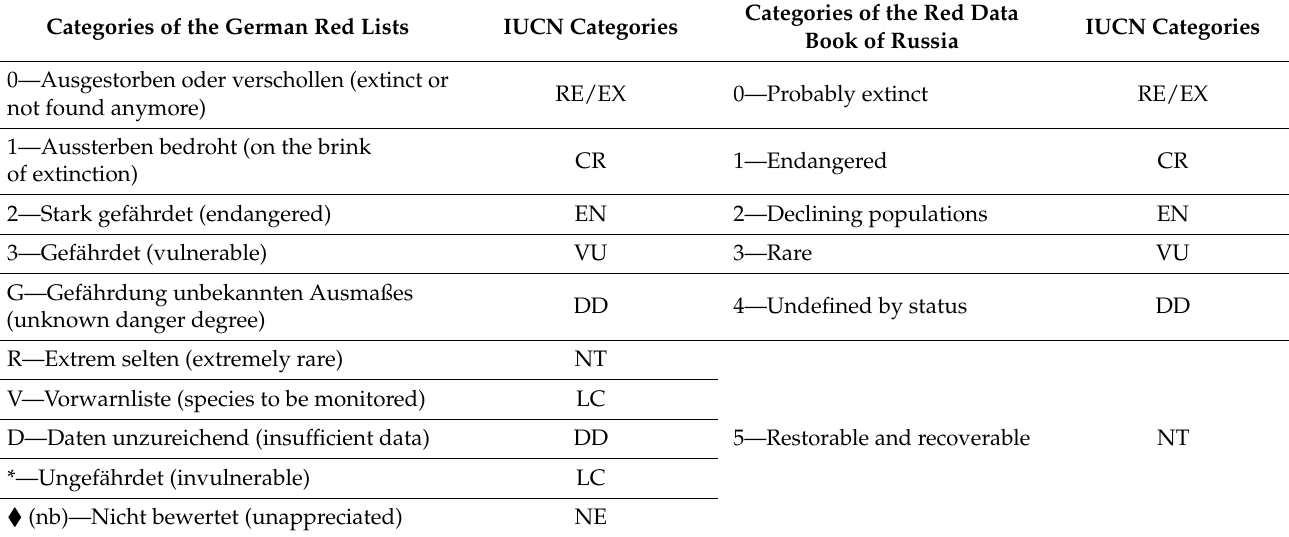
Table 1. Correlation of the German Red Lists and the Red Data Book of Russia with the IUCN Red List